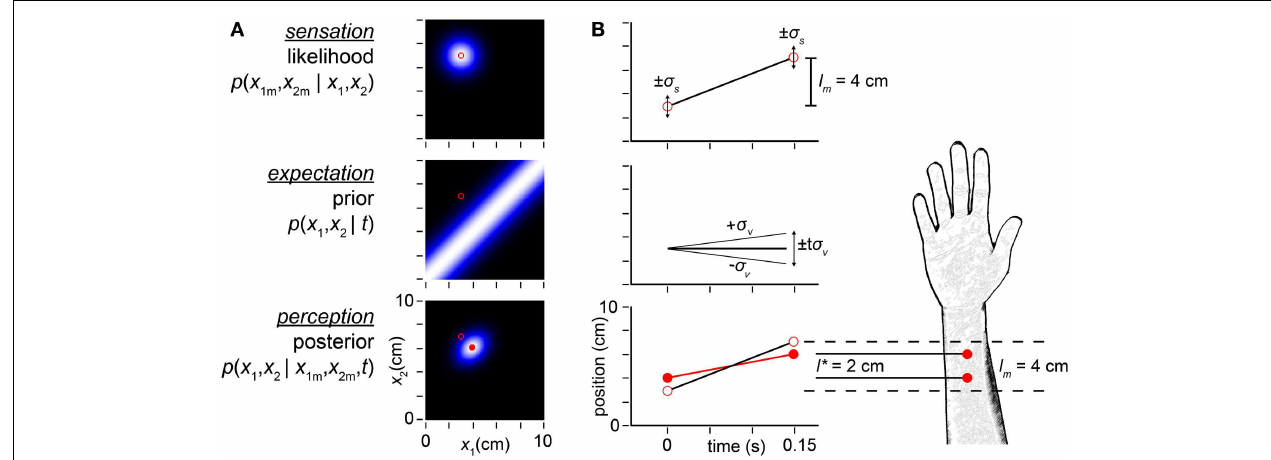
likelihood and prior.The mode of the posterior (filled red circle) is the percept. (B) Space-time plots equivalently illustrate the inference process. Top : open red circles show measured tap positions (vertical-axis) and times of occurrence (horizontal-axis). Error bars ( ± 1 σ s ) represent the spatial imprecision of the measurements.The slope of the line connecting the taps is the measured trajectory speed: l m / t = 4cm/0.15s = 27cm/s. Middle : the observer’s low-speed expectation is represented by the line of slope zero and diagonal lines of slopes ± 1 σ v =± 10cm/s.The distance traversed at speed σ v in time t is t σ v = 1.5cm.The ascending diagonal line is shallower than the measured velocity: 10cm/s < 27cm/s. Equivalently, t σ v = 1.5cm < l m = 4cm. Thus, the measured trajectory violates the observer’s low-speed expectation. Bottom : the perceived trajectory (filled red circles and red line) is a compromise between the measured trajectory (open circles, reproduced from top panel) and expectation (middle panel). Each tap has migrated perceptually by 1cm toward the other, resulting in perceptual length contraction: l * = 2cm < l m = 4cm.The perceived trajectory speed is l * /t = 2cm/0.15s = 13cm/s. In both panels, σ s = 1cm, σ v = 10cm/s, t = 0.15s,